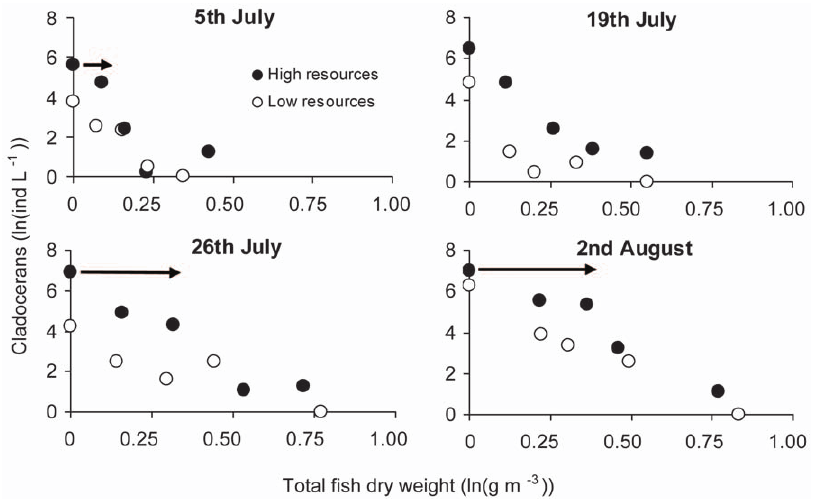
Figure 2. Cladoceran densities (ln transformed) along the gradient of stocked fish biomass in high and low resource enclosures from the 5 th of July to the 2 nd of August. Arrows indicate the threshold at which fish biomass populations crashed in the high resource treatments.